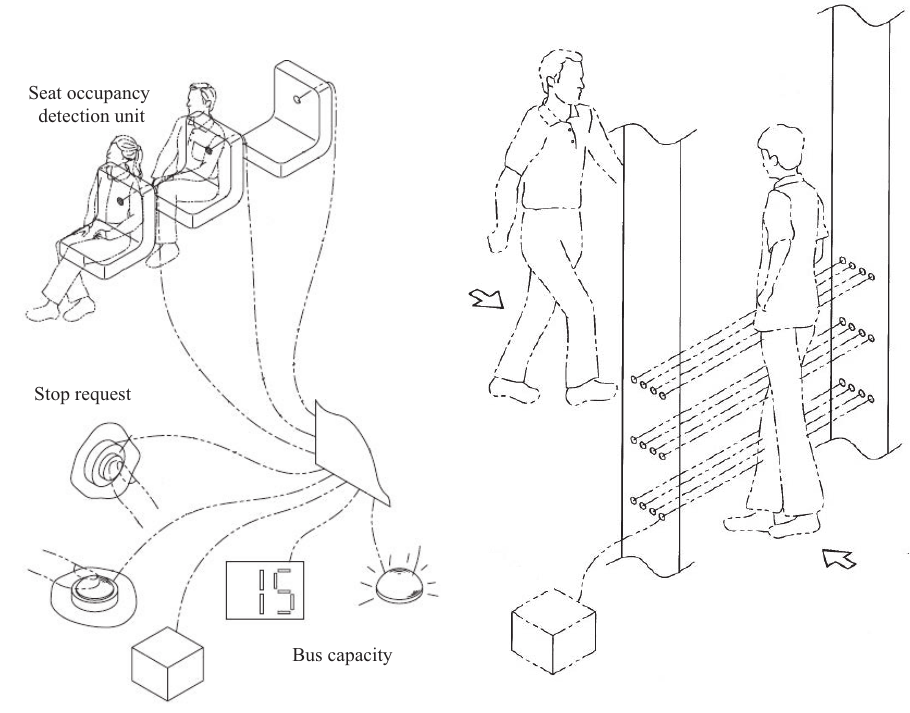
Figure 9. Seat occupancy detection unit ( left ); people counting unit ( right ). The number 15 represents the bus